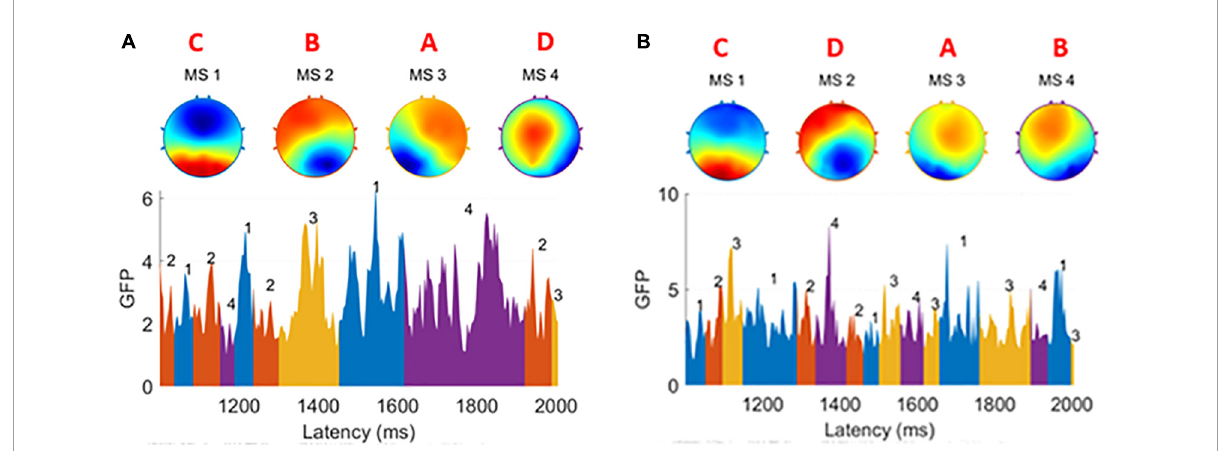
FIGURE2 (A) Four prototype microstates extracted from one healthy subject. (B) Four prototype microstates extracted from one patient subject. The brain topographies are labeled as type A, B, C, and D. In both graphs GFP, the EEG data is divided into small segments. Each of them is corresponding to one of four microstates and a microstate sequence is formed. There are slight differences between the healthy group and the patient group.